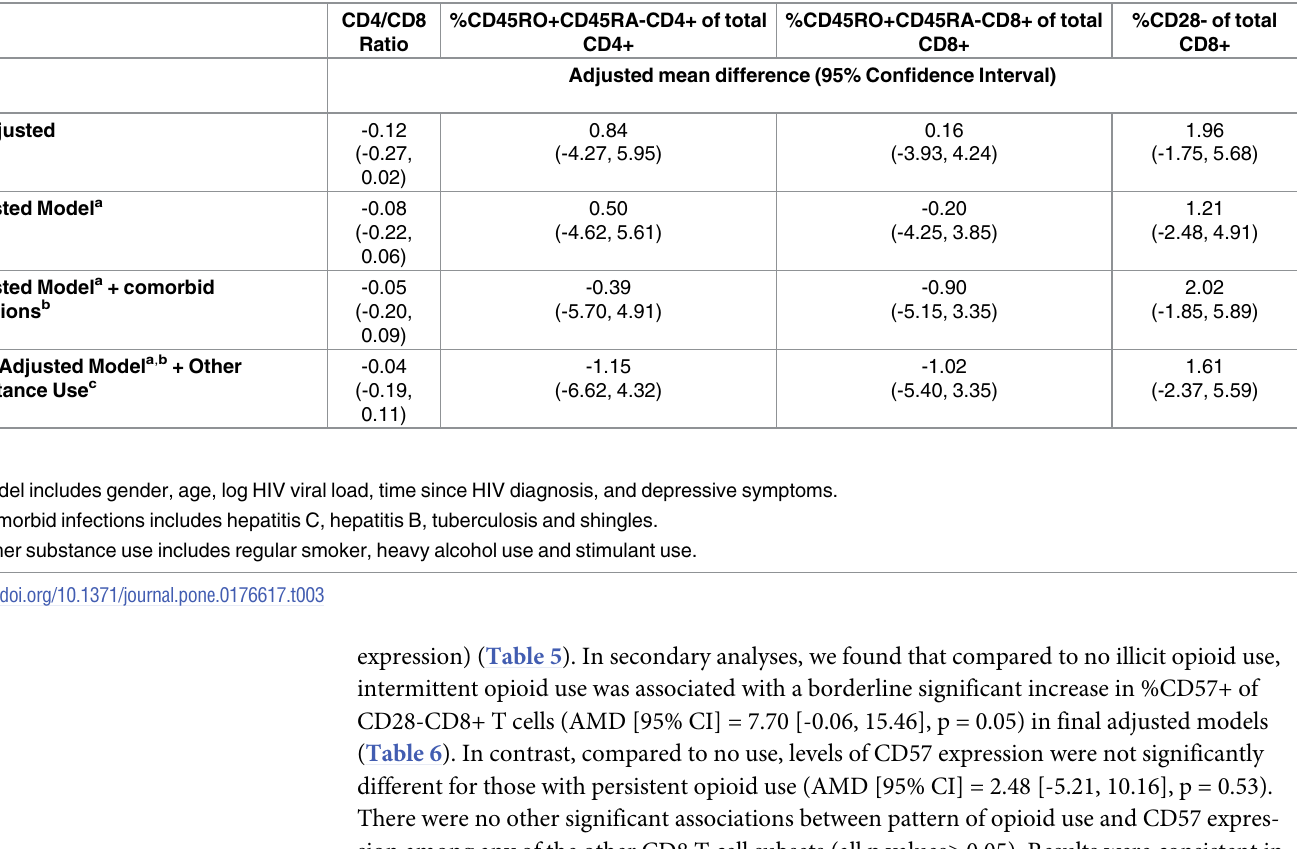
Table 3. Association between illicit opioid use and CD4/CD8 ratio and memory cells, linear regression models.